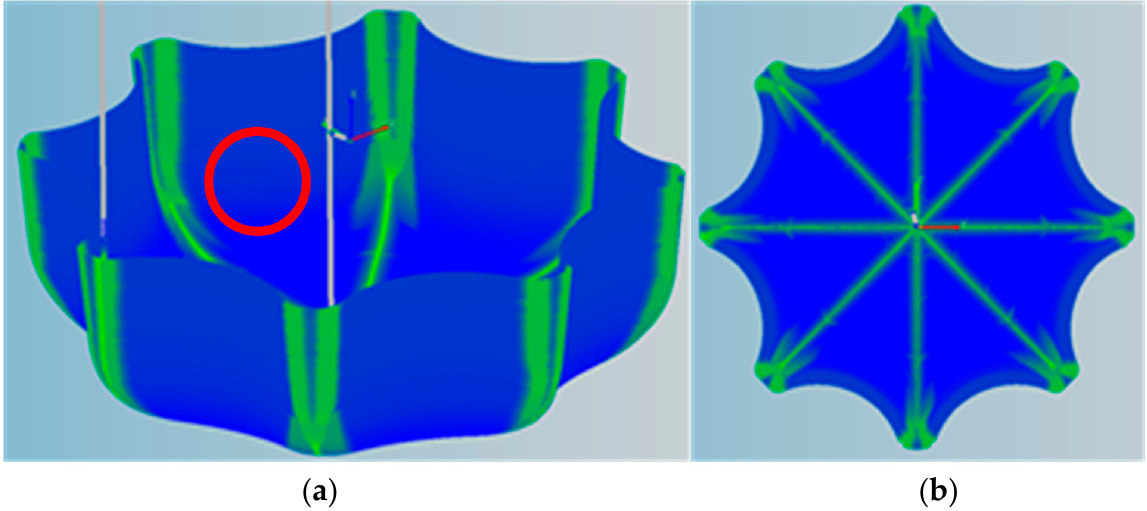
Figure 11. Visualization of Coke Bottom after optimization ( a ) before optimization ( b ) after optimi- zation.